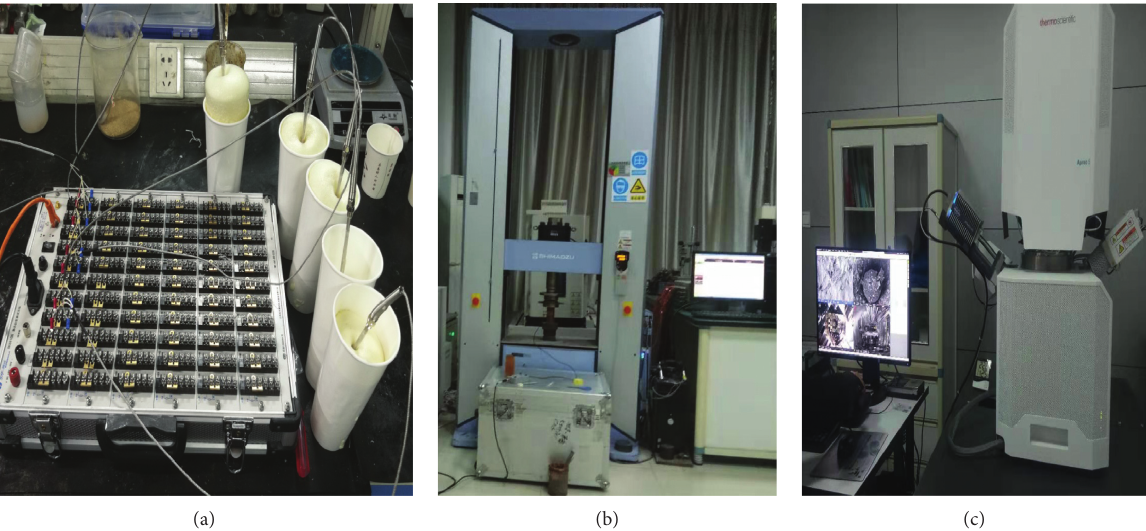
Figure 2: Experimental equipment: (a) dynamic acquisition system and thermocouple sensor; (b) electrohydraulic servo control pressure testing machine; (c) SEM.